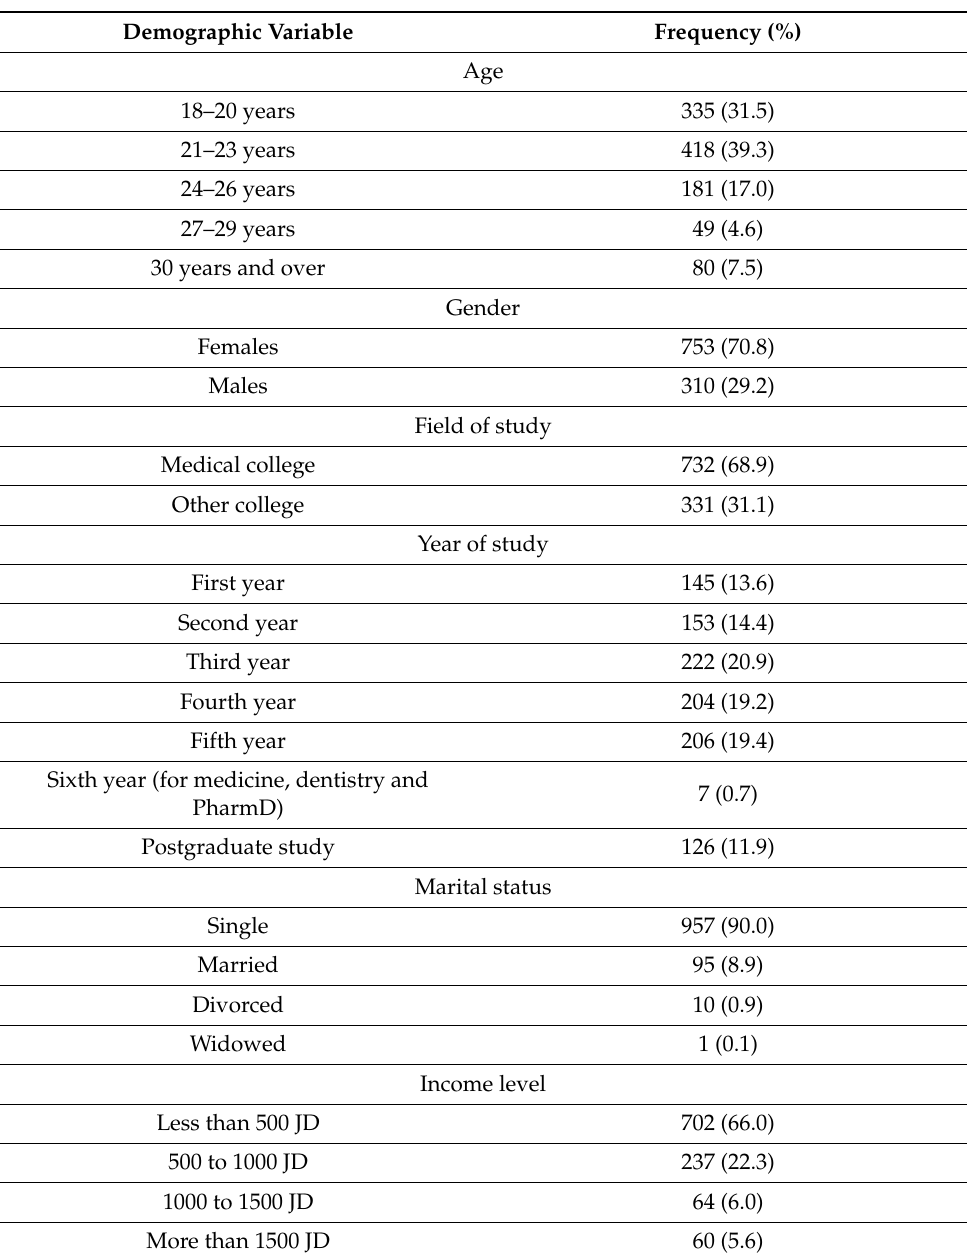
Table 1. Demographic characteristics of the study